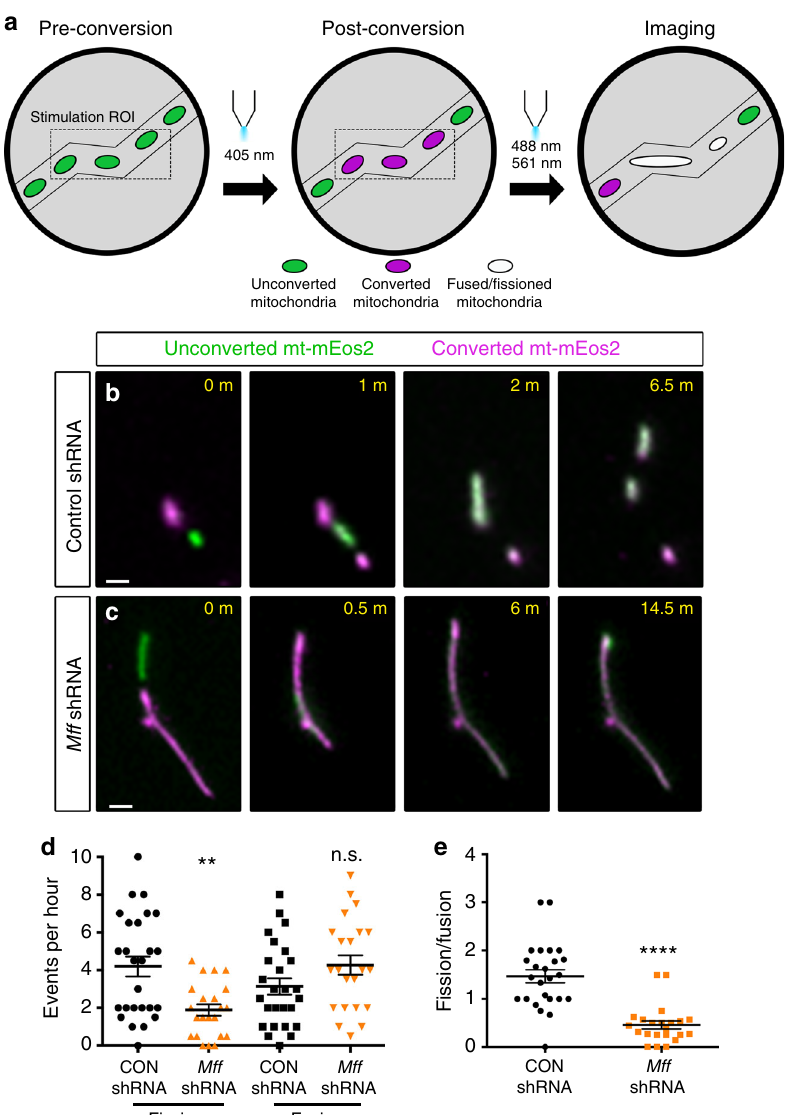
Fig. 3 Loss of MFF reduces axonal fi ssion and reverses fi ssion/fusion balance. a Schematic of the imaging paradigm used for measuring axonal fi ssion and fusion via mitochondria-targeted mEos2 (mt-mEos2), a photoconvertible fl uorescent probe. b Selected timeframes of a mitochondrial fusion and fi ssion event along the axon of a 7DIV neuron ex utero electroporated with control shRNA and mt-mEos2. c Selected timeframes of a mitochondrial fusion event along the axon of a 7DIV neuron ex utero electroporated with a 1:1 mixture of Mff shRNA (539:665) and mt-mEos2. Fusion events are mostly coupled with a subsequent fi ssion event in control axons, whereas in MFF-de fi cient axons, fi ssion is signi fi cantly less frequent following a fusion event. See also Supplementary Movie 2. d Quanti fi cation of the frequency of fi ssion and fusion (#events per hour) per axon segment. Data is represented as a scatter plot with mean ± sem. p = 0.0019 for control vs. Mff shRNA fi ssion, p = 0.1135 for control vs. Mff shRNA fusion. e Quanti fi cation of the fi ssion to fusion ratio per axon segment. Data is represented as a scatter plot with mean ± sem. p < 0.0001 for control vs. Mff shRNA fi ssion/fusion ratio. Mann – Whitney test. n control = 26 axons; n = 22 axons. In both d and e , each dot is a single axon segment. Quanti fi cation from three independent cultures in MFF shRNA shRNA